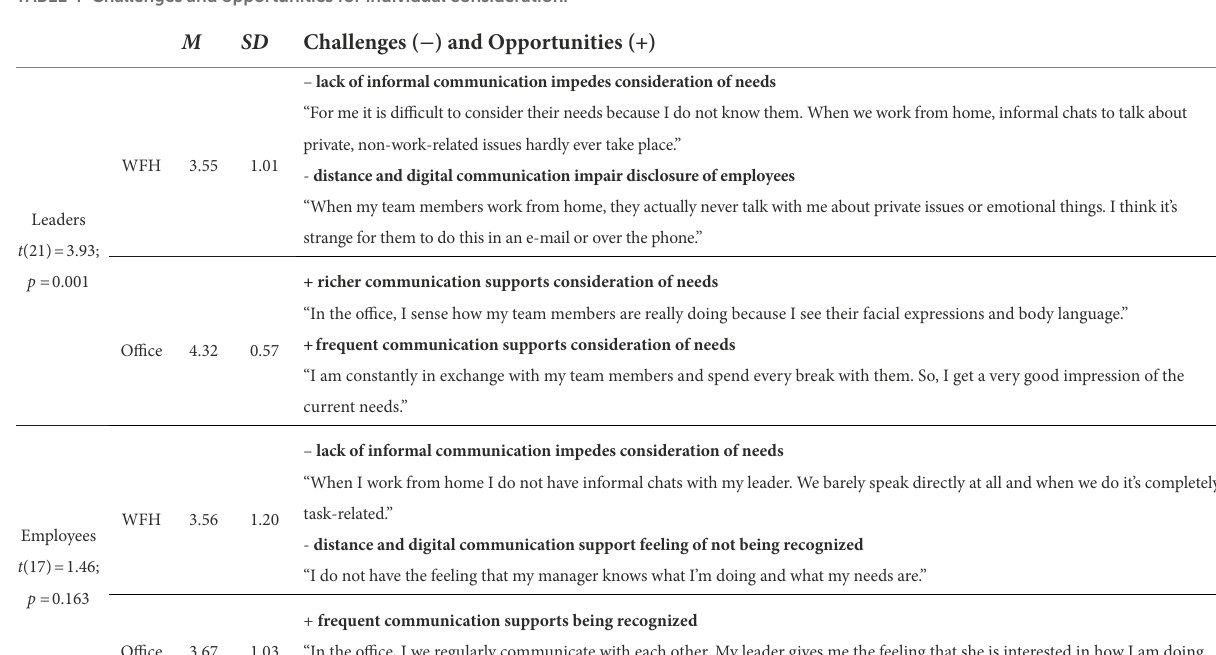
TABLE 4 Challenges and opportunities for individual